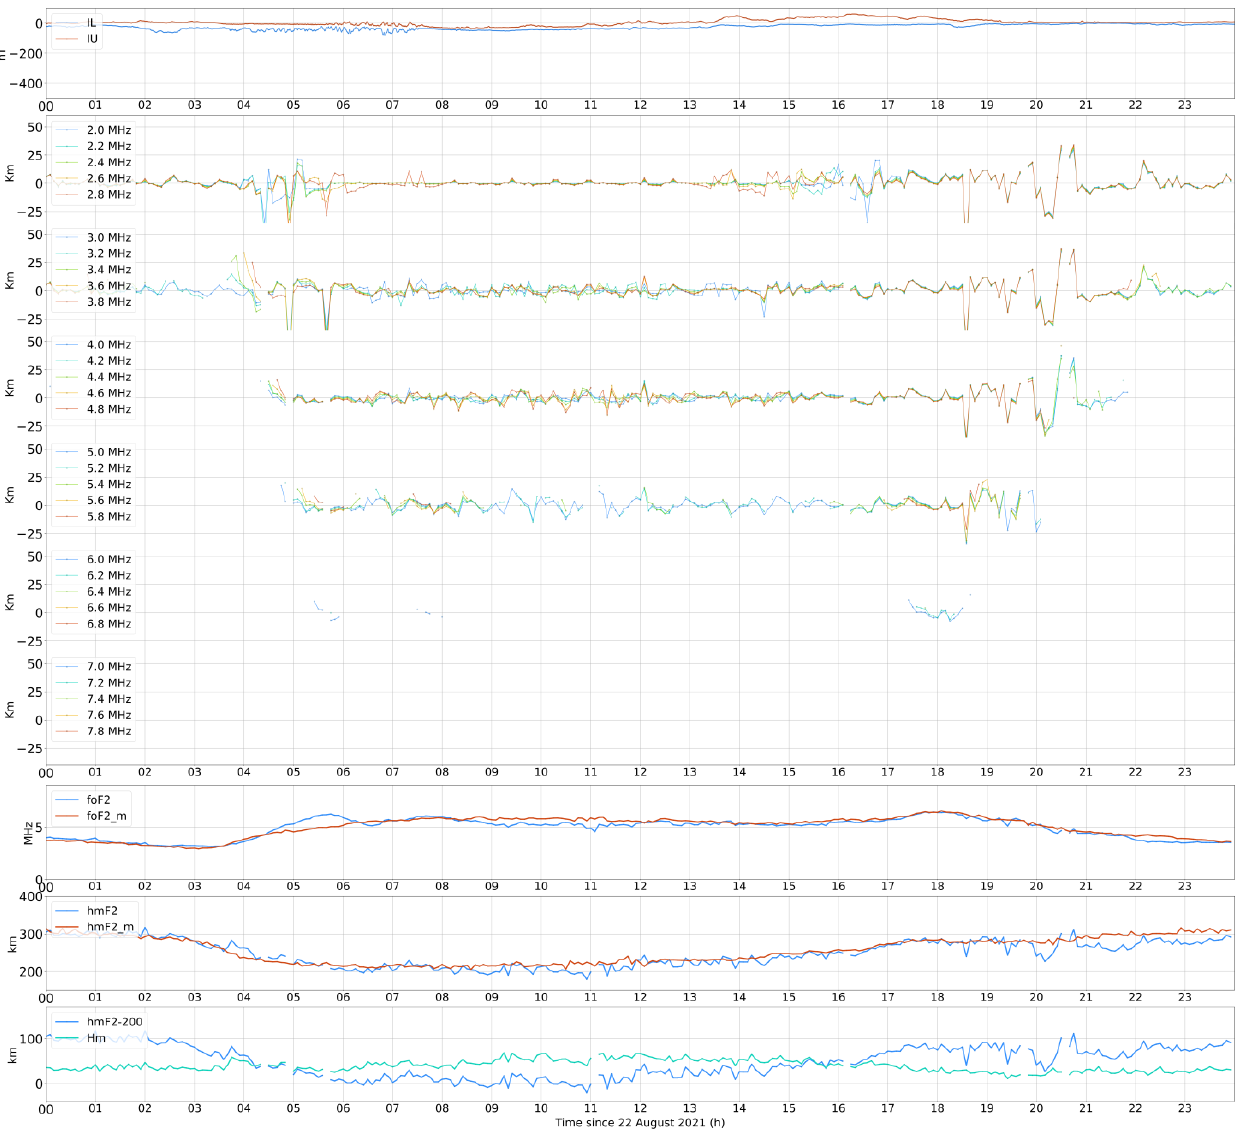
Figure 4. The IU and IL auroral electrojet indicators, together with the detrended height of iso-ionic densities and the variability of the ionospheric characteristics at the height of peak density, during 22 August 2021 over Athens.